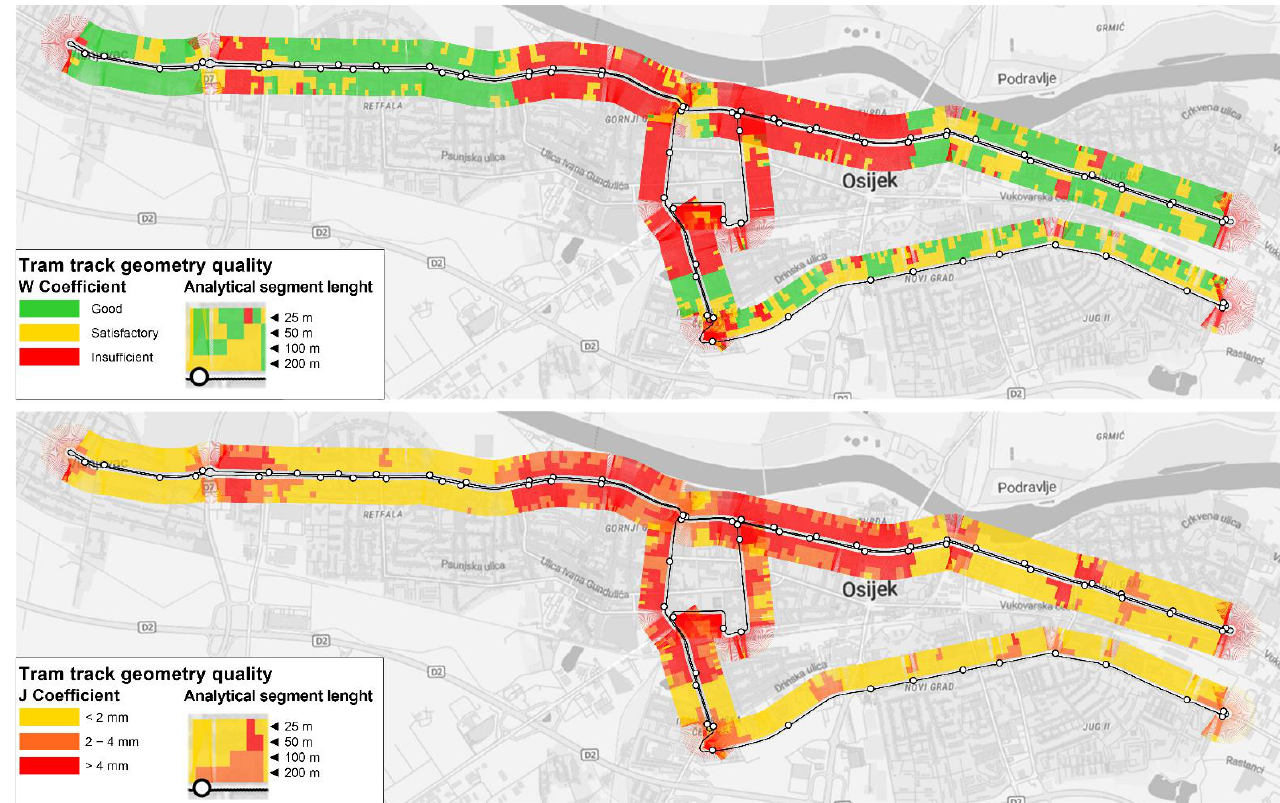
Figure 8. Track quality W and J index distribution along the tracks.